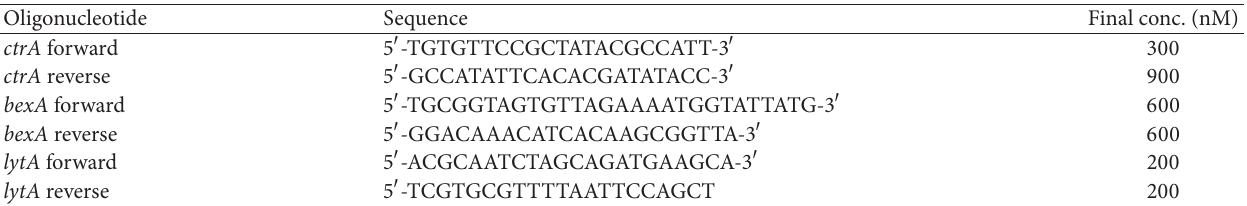
Figure 1: (a) Real-time PCR amplification plot for lytA gene specific for Streptococcus pneumoniae . Horizontal blue line represents the threshold value of fluorescence. (b) Melting curves of positive samples for Streptococcus pneumoniae . Table 1: Real-time PCR primers [9].